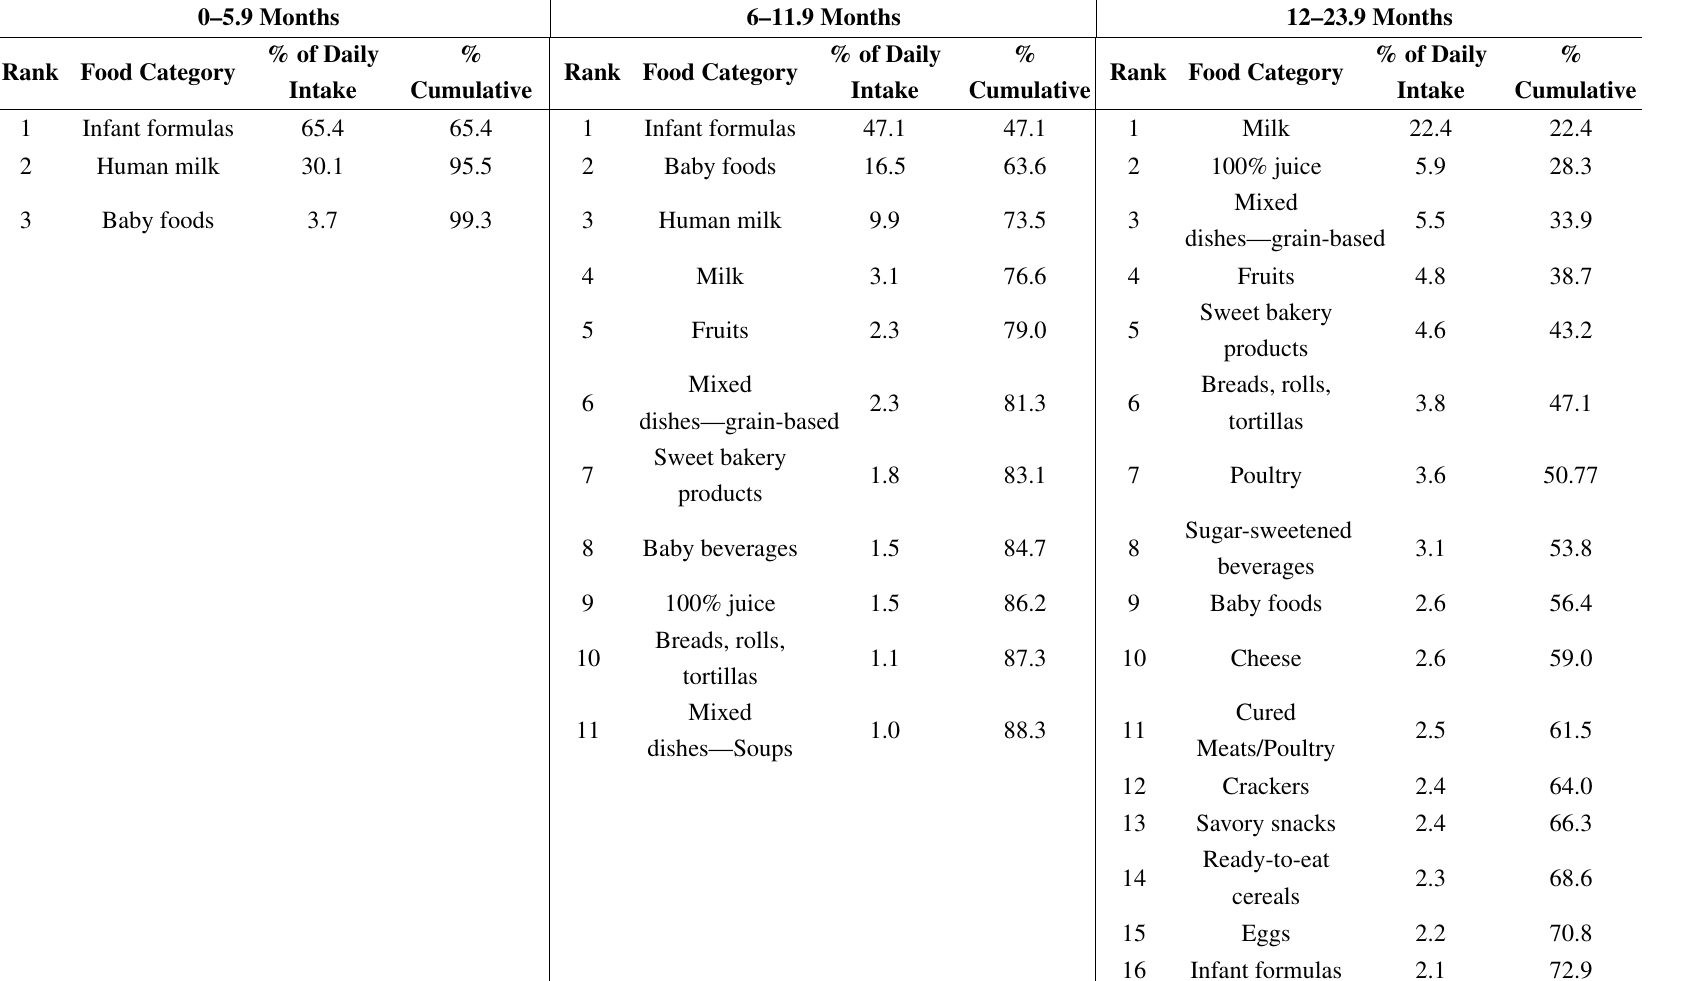
Table 2. Food sources of total energy among US infants and toddlers aged 0–23.9 months by age group: NHANES 2005–2012 ( n = 2740) a